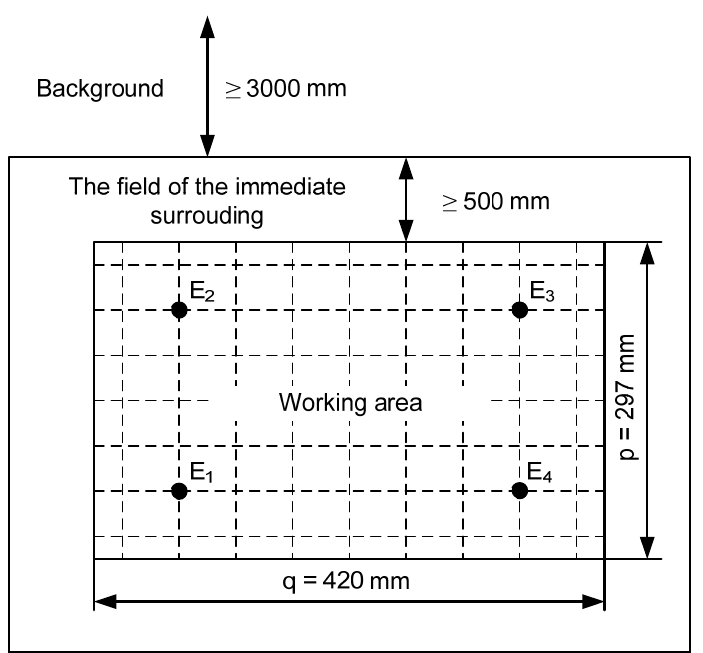
Figure 1. Working area